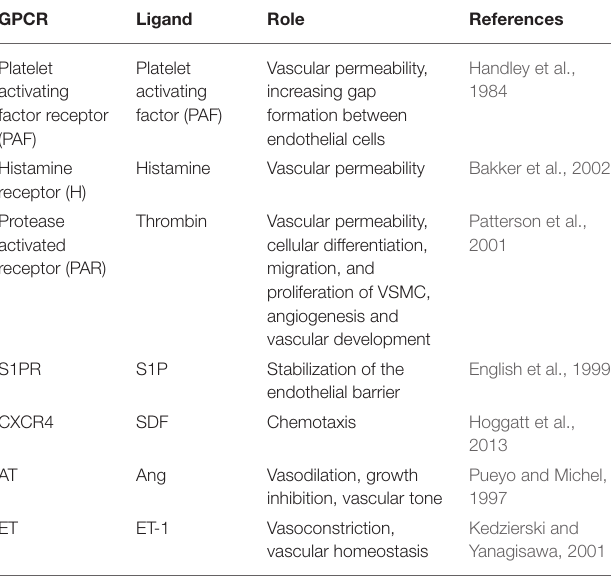
TABLE 3 | GPCRs present in human endothelial